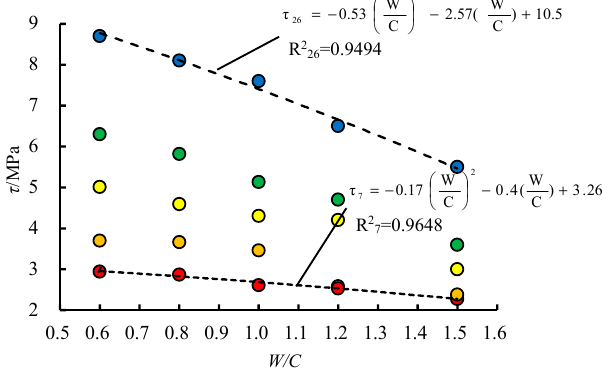
Figure 9. Characteristics between N and ττ .